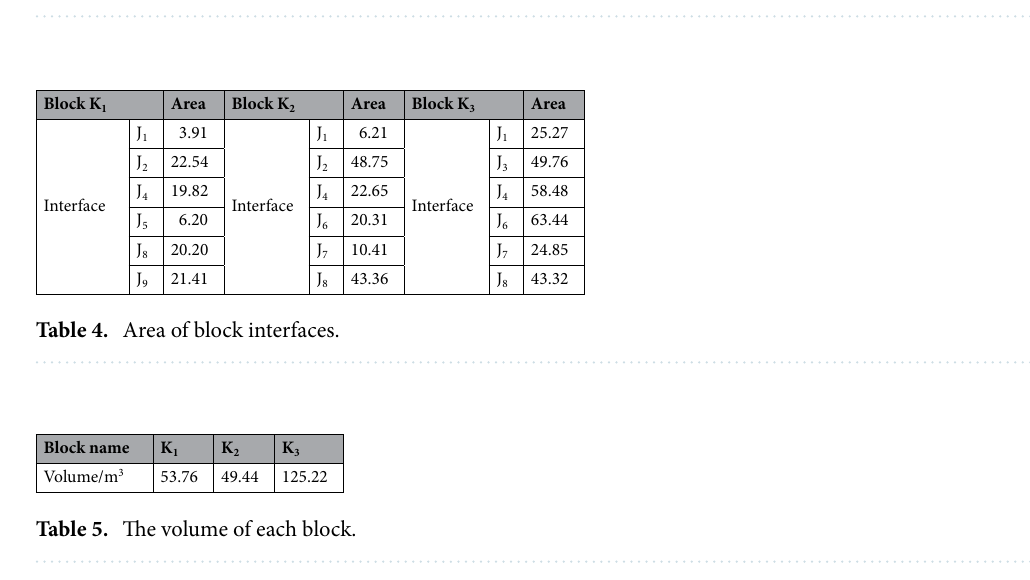
Table 3. The coordinate values of block vertices obtained from the cross-section diagram.